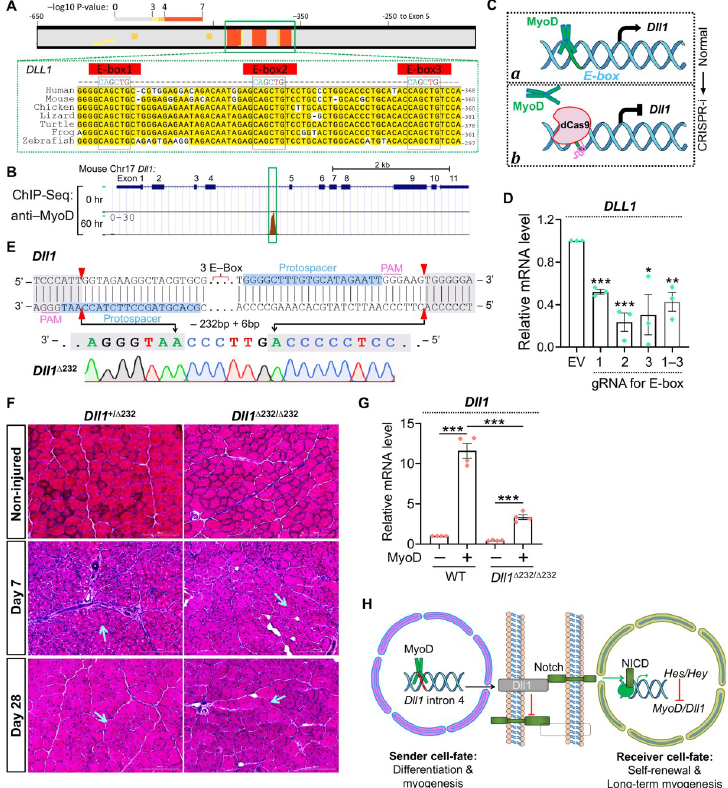
Fig 9. Regulation of Dll1 expression by MyoD through intronic E-box elements in human and mouse cells. ( A ) Bioinformatic predictions of MyoD binding motifs in the Dll1 intronic regions from distantly related mammalian species. ( B ) ENCODE ChIP-seq results of MyoD from mouse myoblasts. Green box highlights the mouse sequence displayed in A. ( C ) Schematic of experiment design and rationale to probe cis- regulatory elements by dCas9 mediated interference. CRISPRi: CRIPSR interference; ( D ) qPCR results of human WT myoblasts with expression of dCas9 and gRNA indicated. n = 3. ( E ) Sequencing result of mouse Dll1 Δ 232 mutant allele generated by CRISPR/Cas9 mediated gene targeting. ( F ) H&E staining results of cross-sections from control and injured tibialis anterior muscles. Arrows point to regenerated myofibers with centronuclei. Scale bar, 200 μ m. ( G ) qPCR results that measured Dll1 expression in mouse fibroblasts that infected by control or MyoD-expressing retroviruses. n = 4. ( H ) Schematic summary of transcriptional regulations and ligand-receptor interactions between Notch signal sending or receiving cells. Data are means ± SEM. � P < 0.05, �� P < 0.01, ��� P <